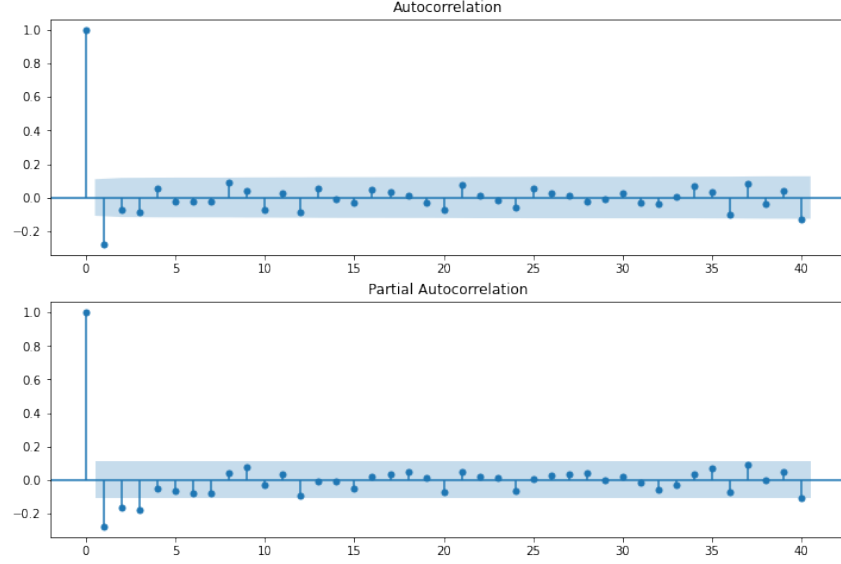
Figure 5. Autocorrelation function and partial autocorrelation function for ∆ log ( p t ) of product